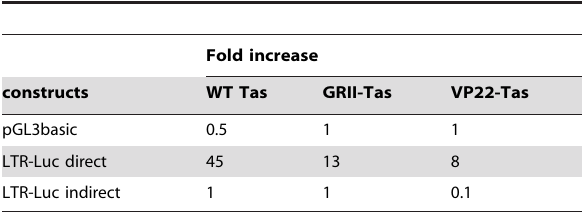
Table 1. Lucifarase activity following transactivation of the PFV